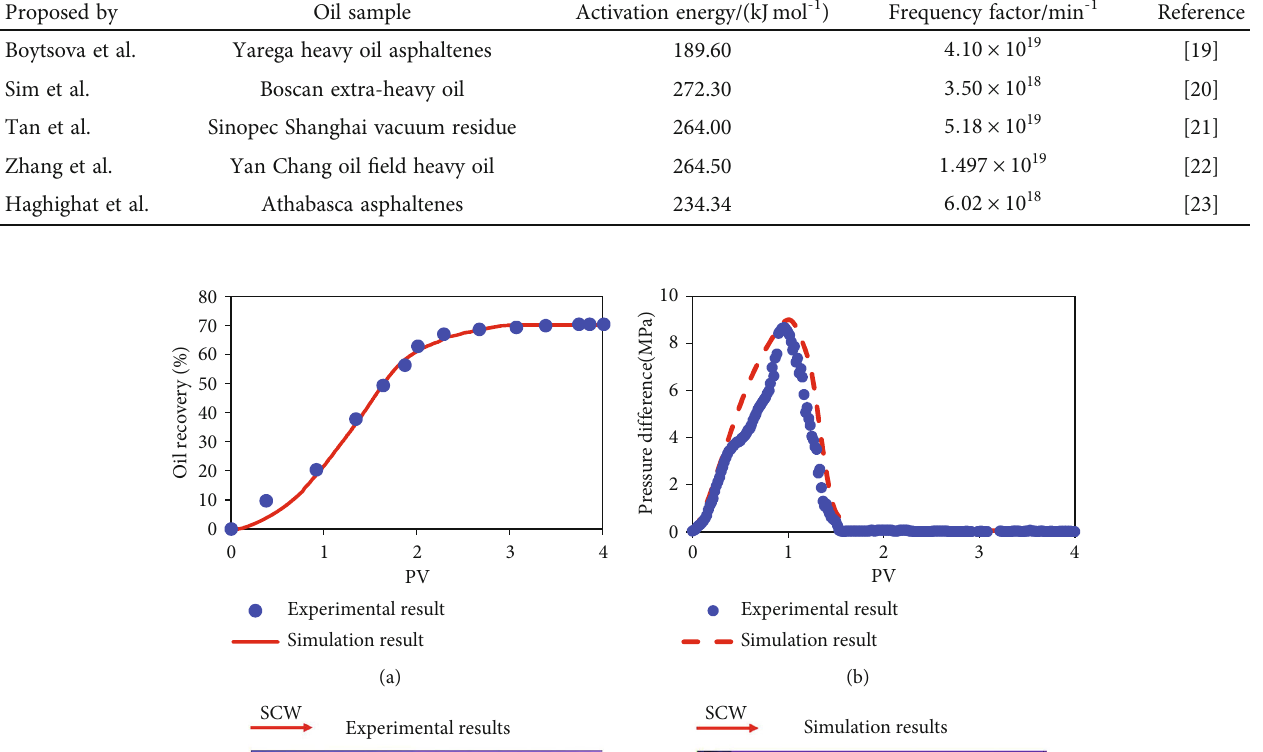
Table 2: Summary of the heavy oil upgrading kinetic